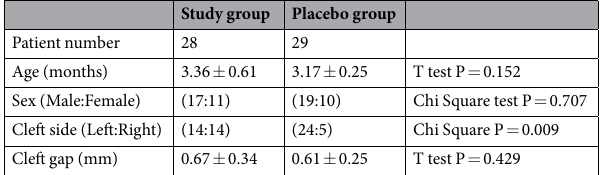
Table 1. The patients’ demographics and the cleft gap width before